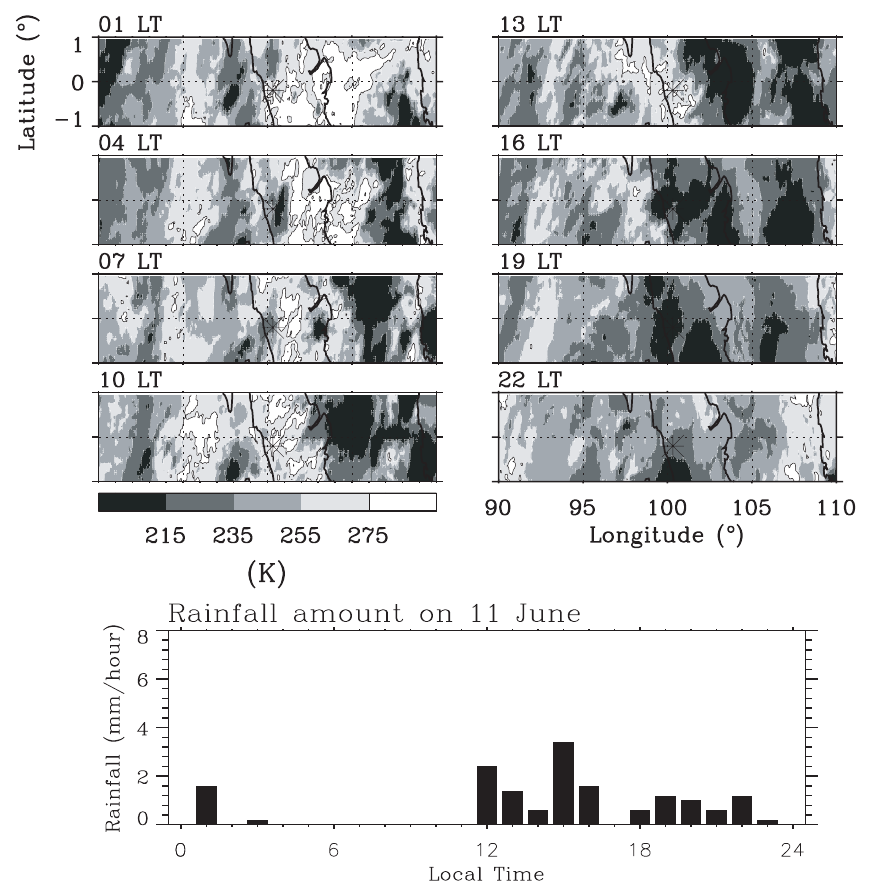
Fig. 17. Same as Fig. 15 except for 11 June 2002, and that T BB is shown every 3h during 01:00–22:00 LT and the range of vertical axis in the lower panel is 0–8mmh − 1